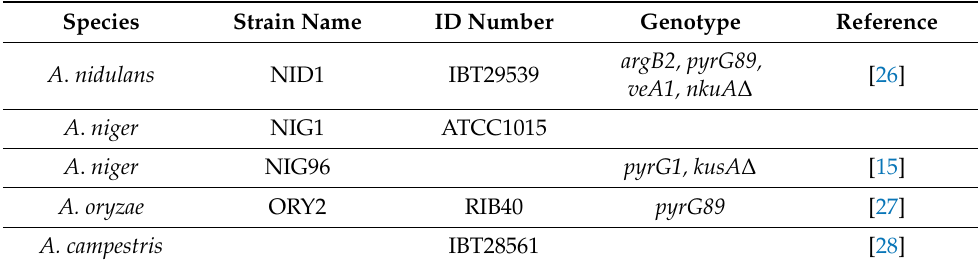
Table 1. Fungal strains used in this